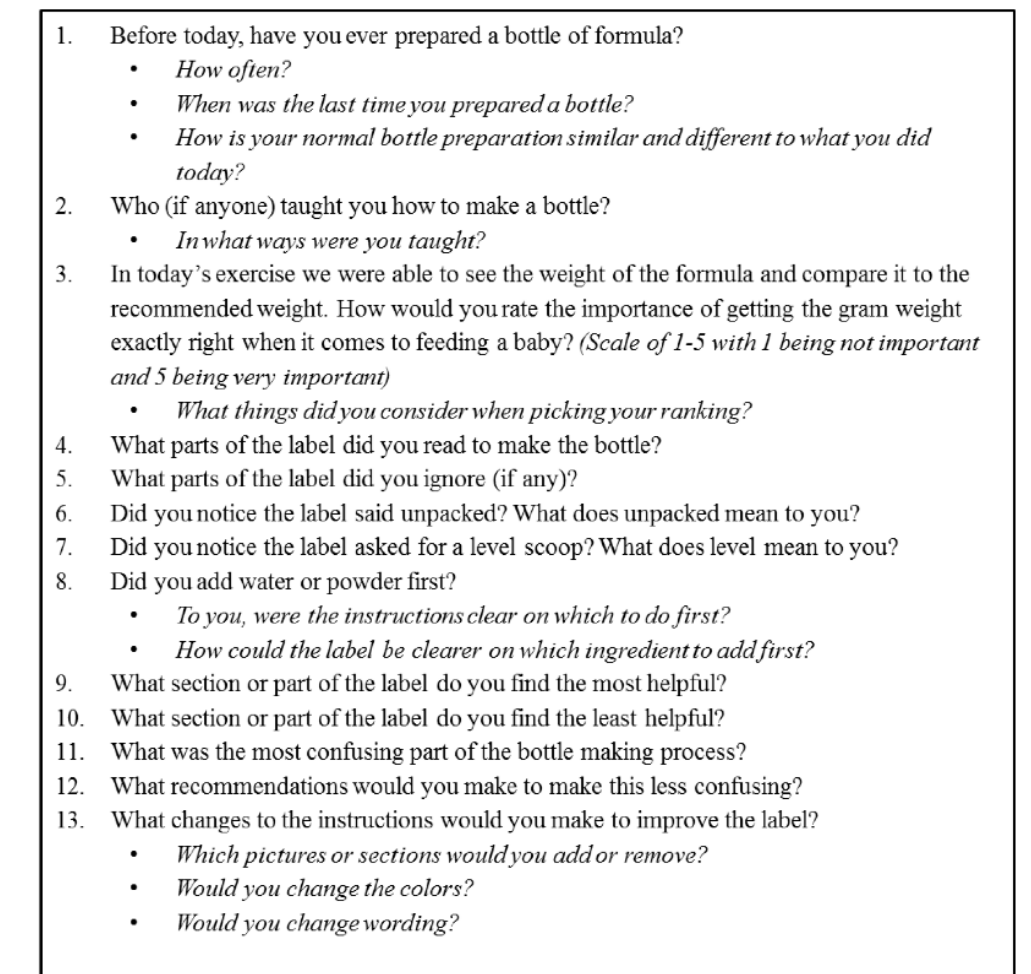
Figure 2. Focus Group Questions.